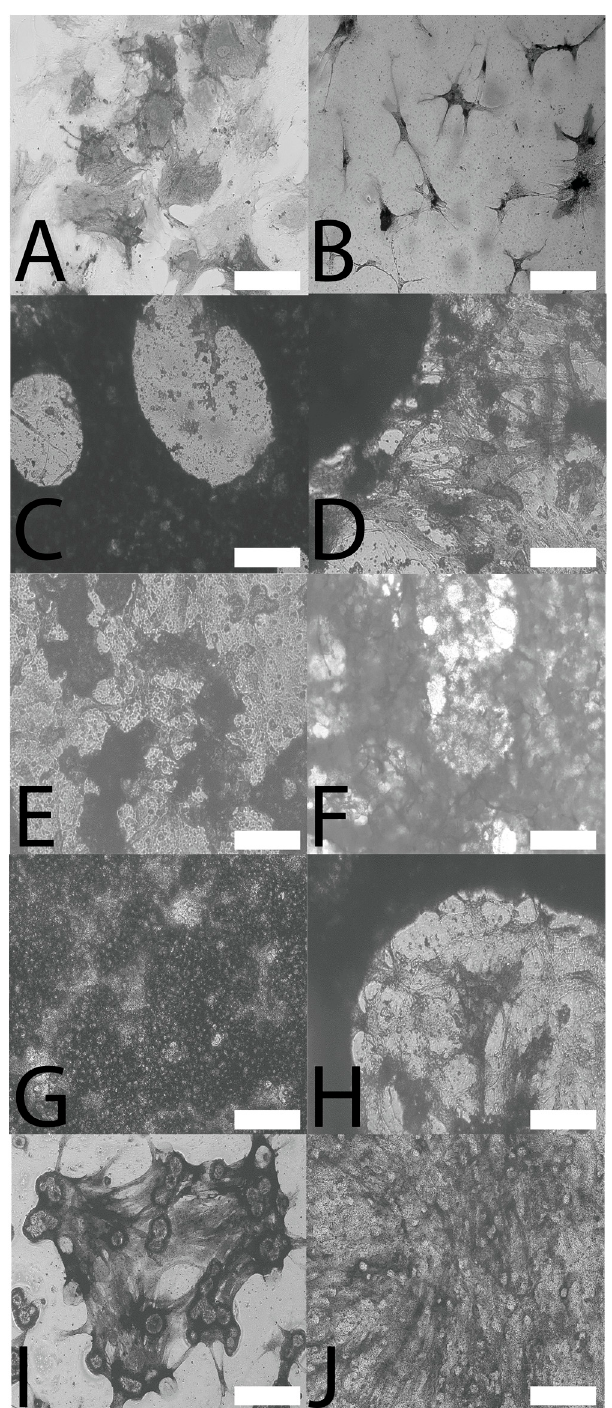
Figure 3. ( A – J ) Qualitative analysis of the ALP activity of stem cells on films mineralized with calcium phosphate using bright field microscopy after ALP live staining; ( A ) Nunclon ® Δ ; ( B ) eADF4(C16)-CaPO 4 ; ( C ) PBT-25-CaPO 4 ; ( D ) PBT-50-CaPO 4 ; ( E ) PBT-75-CaPO 4 ; ( F ) PBT-100-CaPO 4 ; ( G ) PBTAT-25-CaPO 4 ; ( H ) PBTAT-50-CaPO 4 ; ( I ) PBTAT-75-CaPO 4 ; ( J ) PBTAT-100-CaPO 4 . Scale bars represent 200 µm.